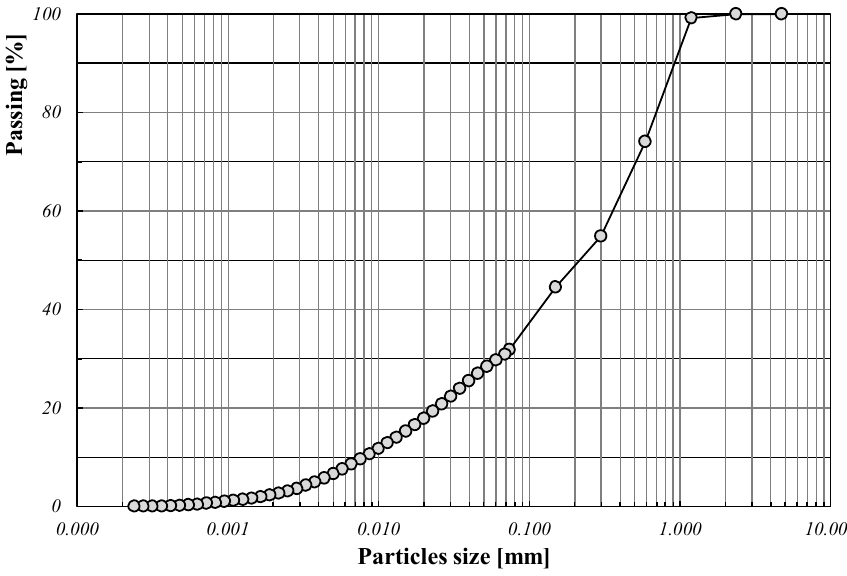
Figure 1. Grain size distribution for lime-based matrix.